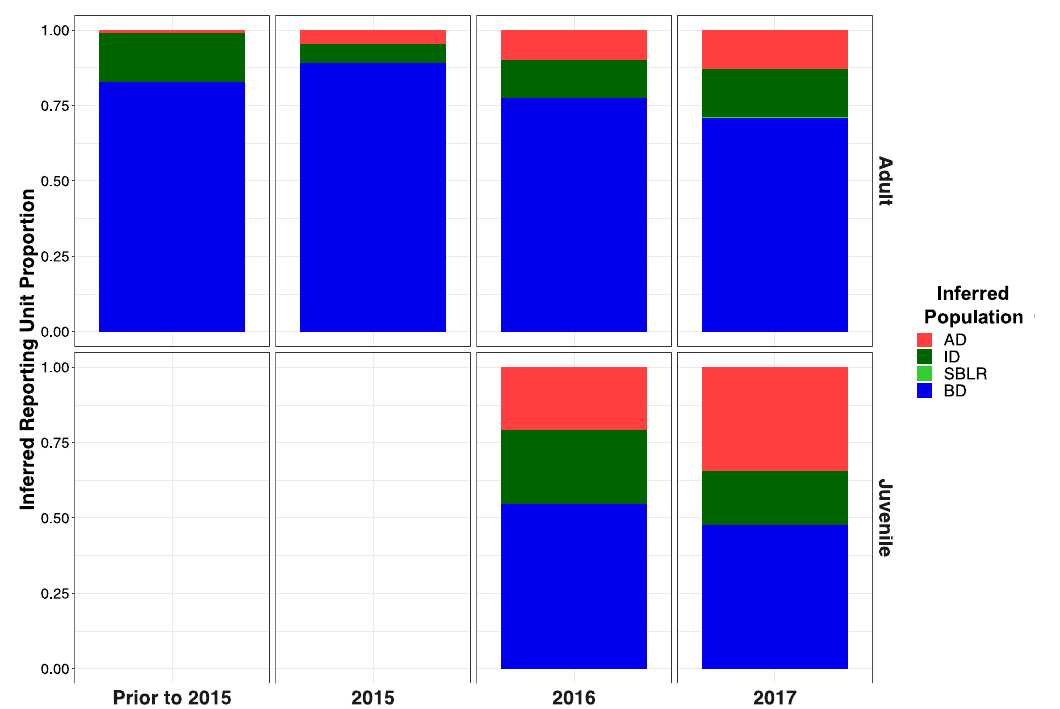
Figure A2. Inferred proportion of genetic ancestry from each of the four inferred populations across Figure A1. Inferred proportion of genetic ancestry from each of the four inferred populations across recolonizing adult and Figure A1. Inferred proportion of genetic ancestry from each of the four inferred populations across recolonizing adult and juvenile steelhead smolt life history cohorts from the GSI analysis (iii). Rela- recolonizing adult and juvenile steelhead smolt life history cohorts from the GSI analysis (ii). Colors juvenile steelhead smolt life history cohorts from the GSI analysis (ii). Colors are representative of the inferred population. tive proportions of genetic ancestry from BD populations were greater in adult life history cohorts are representative of the inferred population. The bottom x axis divides life history cohorts tempo- The bottom x axis divides life history cohorts temporally and the right y axis divides them by life history stage. Relative in GSI analysis (iii) compared to GSI analysis (i) GSI analysis (ii). rally and the right y axis divides them by life history stage. Relative proportions of genetic ancestry proportions of genetic ancestry from ID populations were greater in adult life history cohorts in GSI analysis (ii) compared from ID populations were greater in adult life history cohorts in GSI analysis (ii) compared to GSI to GSI analysis (i) and GSI analysis (iii). analysis (i) and GSI analysis (iii).